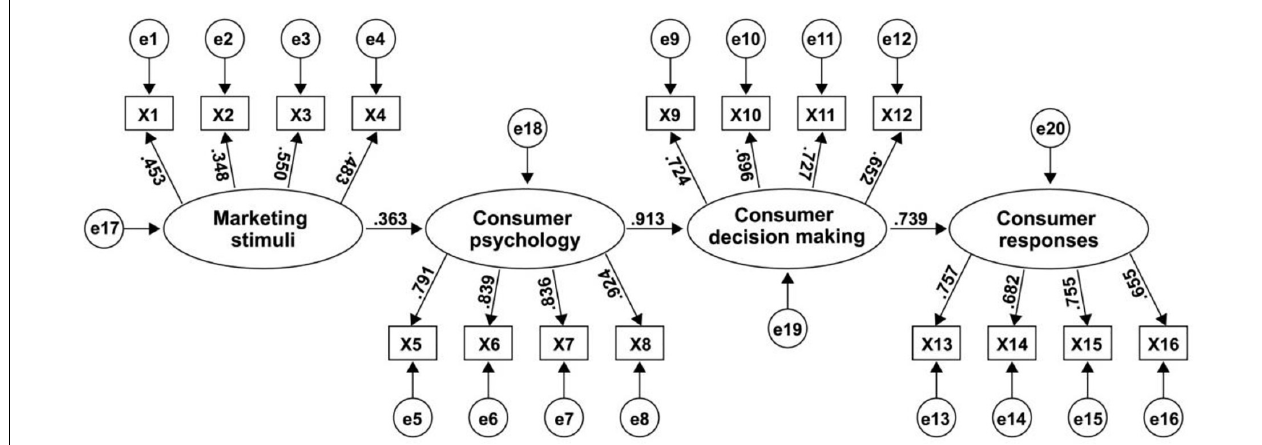
FIGURE 3 | Structural equation modeling results. Comparative fit index = 0.850; goodness-of-fit index = 0.887; root mean square error of approximation = 0.075; degrees of freedom = 136; chi-square = 1,029.143; X1–X16 is the scale items code and e1–e20 is statistical error of four latent variables and 16 scale